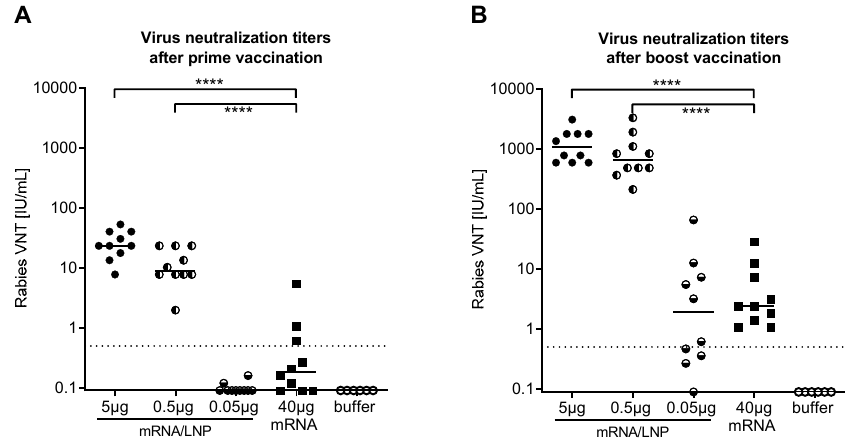
Figure 4. Serum neutralizing antibody responses to mRNA-LNP formulations in mice (adapted from reference [41]). ( A ) shows rabies virus neutralizing antibody titers (VNT) measured in serum of Balb/c mice three weeks after the second of two intradermal vaccinations given 3 weeks apart; vaccinations consisted of 0.05, 0.5, or 5 μ g mRNA-LNP or 40 μ g nonformulated mRNA or buffer. ( B) shows VNT titers measured in serum of Balb/c mice two weeks after the mice received a booster dose of the same vaccine five months after the primary doses. Groups of ten mice were in each case. Dashed line shows WHO protective value (0.5 IU/mL), **** = p < 0.0001; Lipid nanoparticle (LNP)-formulated mRNA was generated using LNPs provided by Acuitas Therapeutics (Canada).